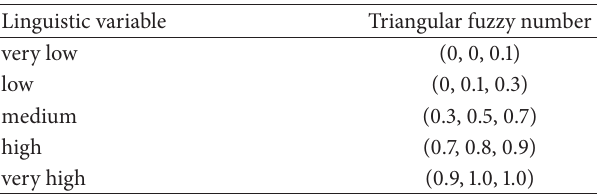
Table 5: Assignment of triangular fuzzy numbers to linguistic variables for rating relative importance